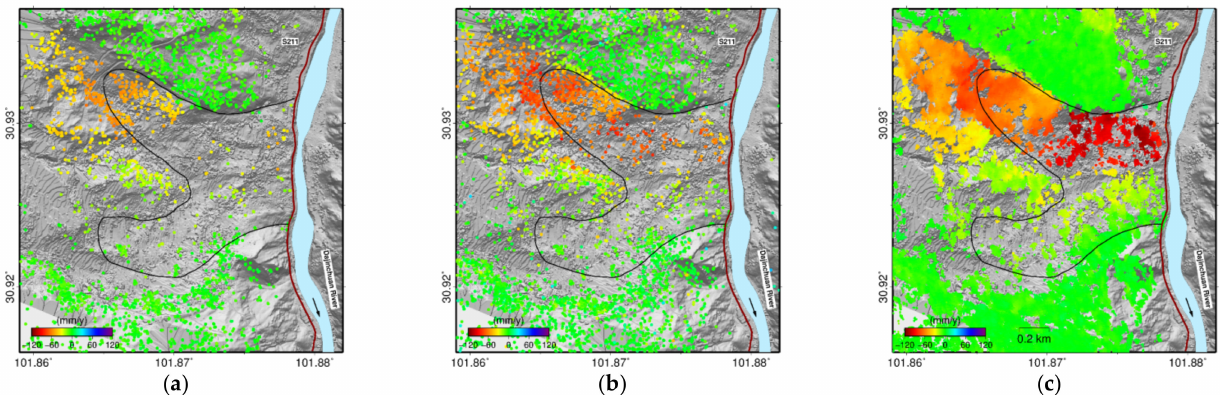
Figure 4. Results of time series InSAR analyses over the Jiaju landslide in Danba derived from L-Band ALOS PALSAR data by different approaches: ( a ) PSI, ( b ) SBAS, and ( c ) CSI. The Dadu River flows from north to south through the landslide